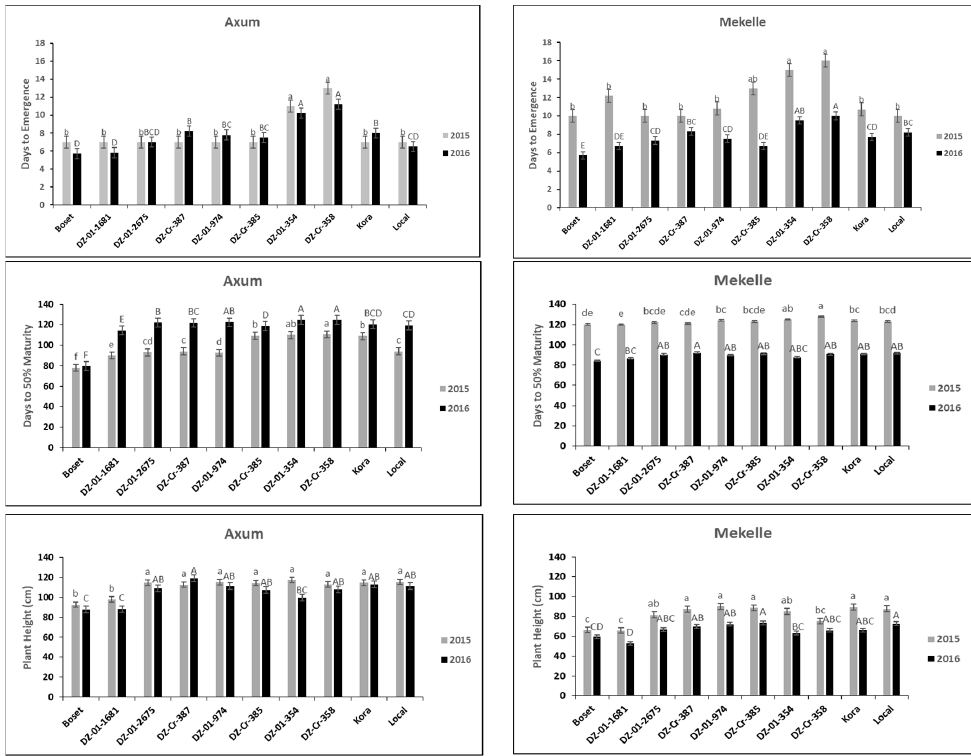
Figure 1. Differences of teff varieties in days to emergence, days to maturity, and plant height in Axum and Mekelle in 2015 and 2016. Means of the teff varieties were compared separately within each location and year considering the main effect of variety. Means with the same letter are not significantly different.